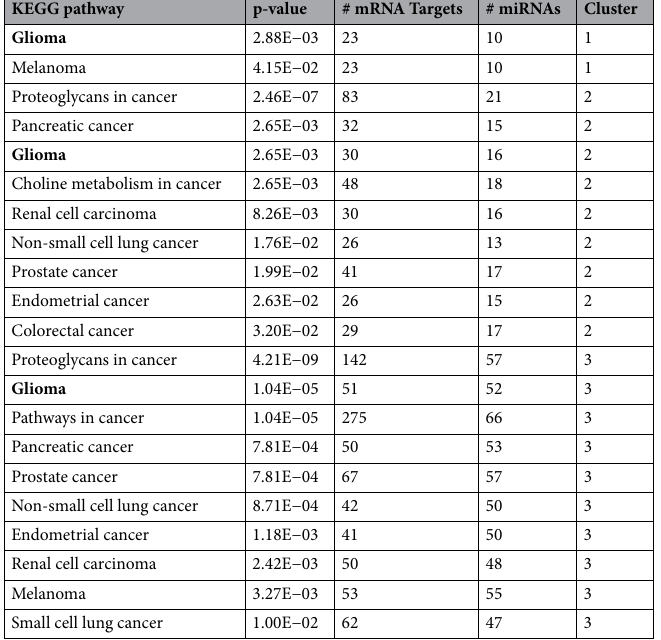
Table 6. Top 10 FDR Significant, cancer related, KEGG Pathways associated with the human milk extracellular vesicle miRNAs in clusters 1, 2 and 3 determined with microT-CDS. KEGG Kyoto Encyclopedia for genes and genomes, FDR false discovery rates. Bold: Pathways shared between all clusters.